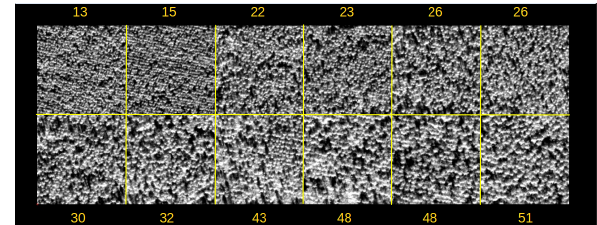
Figure 1: Panchromatic test frame, sorted by increasing age